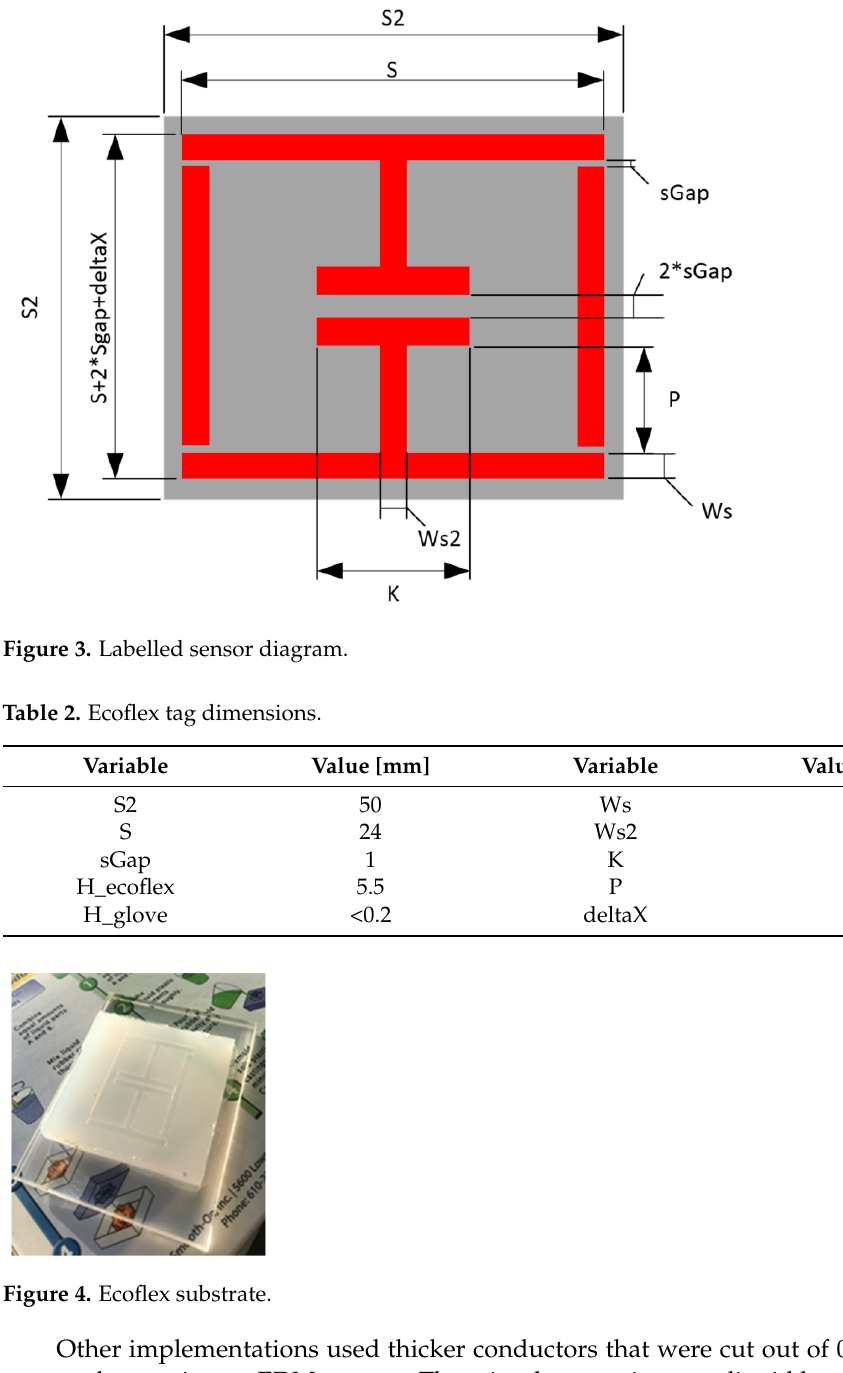
Table 2. Ecoflex tag dimensions.